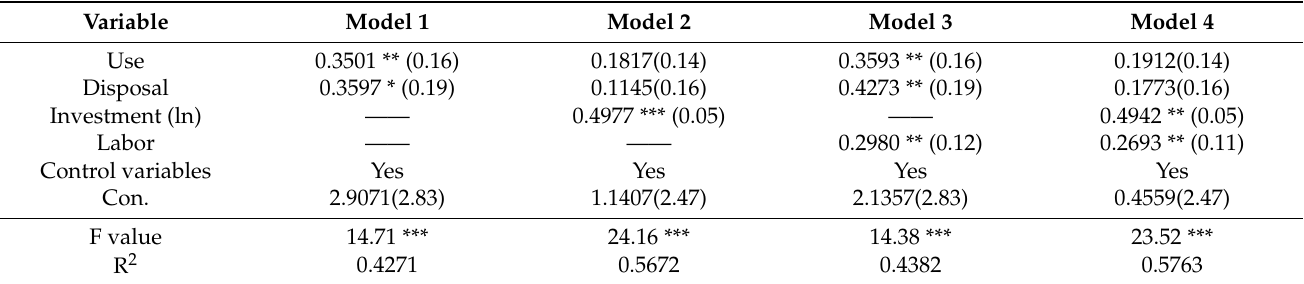
Table 5. Regression results for the intermediary effect.